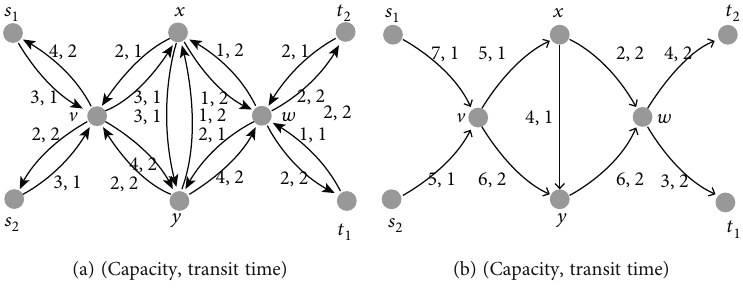
Figure 2: (a) Given network and (b) auxiliary network of